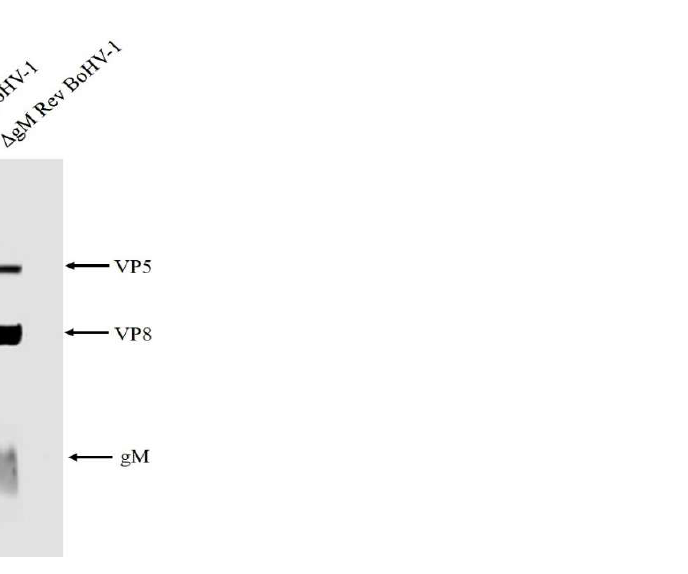
Figure 12. Amounts of VP8 present in virus purified from cells infected with WT BoHV-1, ΔgM BoHV-1, or ΔgM Rev BoHV-1. VP8 was detected using VP8-specific monoclonal antibody. The amount of VP8 was reduced to 33.8% in ΔgM BoHV-1 compared to 100% in WT BoHV-1 and 89.2% in ΔgM Rev BoHV-1.